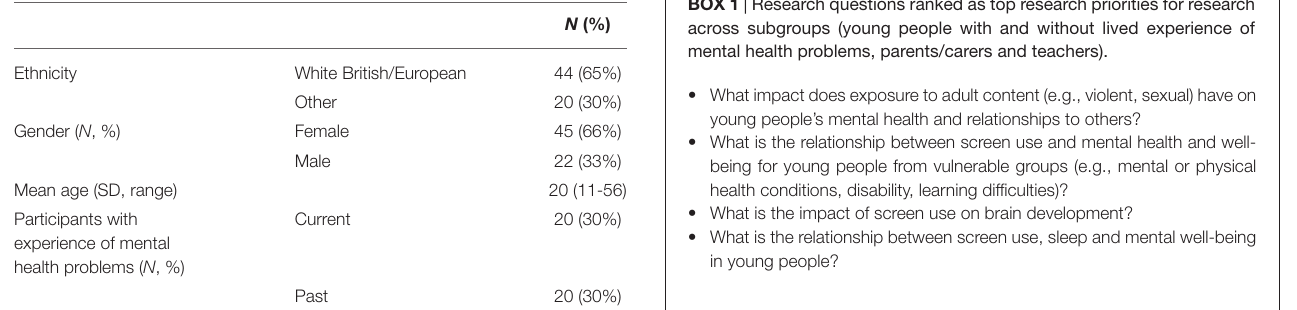
TABLE 1 | Discussion group sample description.